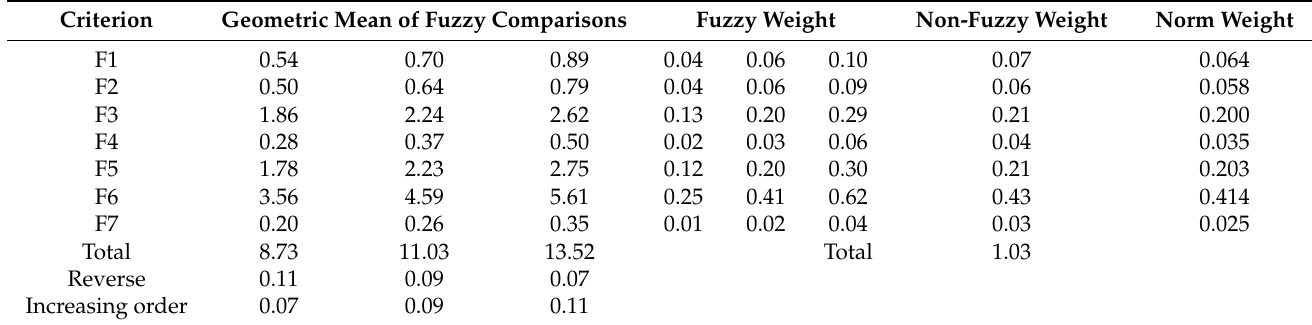
Table A6. The geometric means of fuzzy comparisons for job features, fuzzy weights, non-fuzzy weights, and crisp weights. Criterion